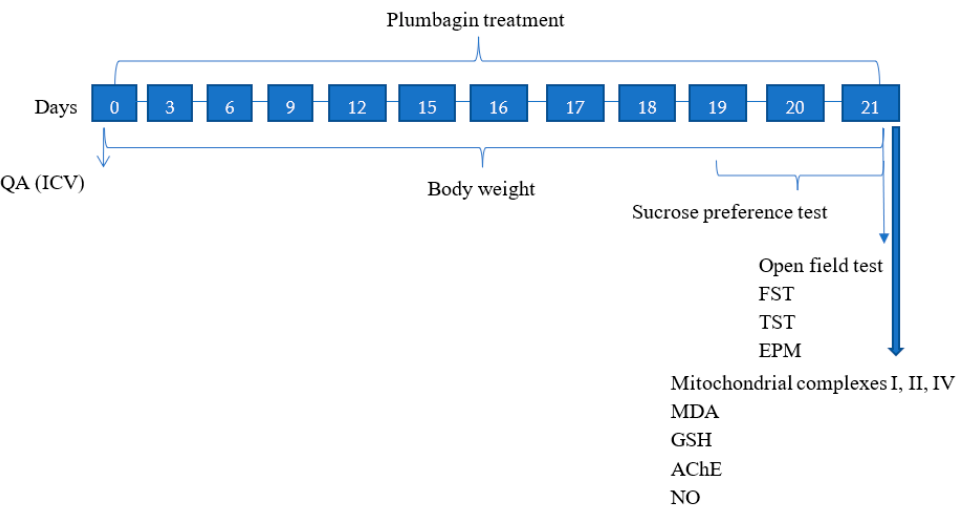
Figure 12. Schematic illustration of the experimental study